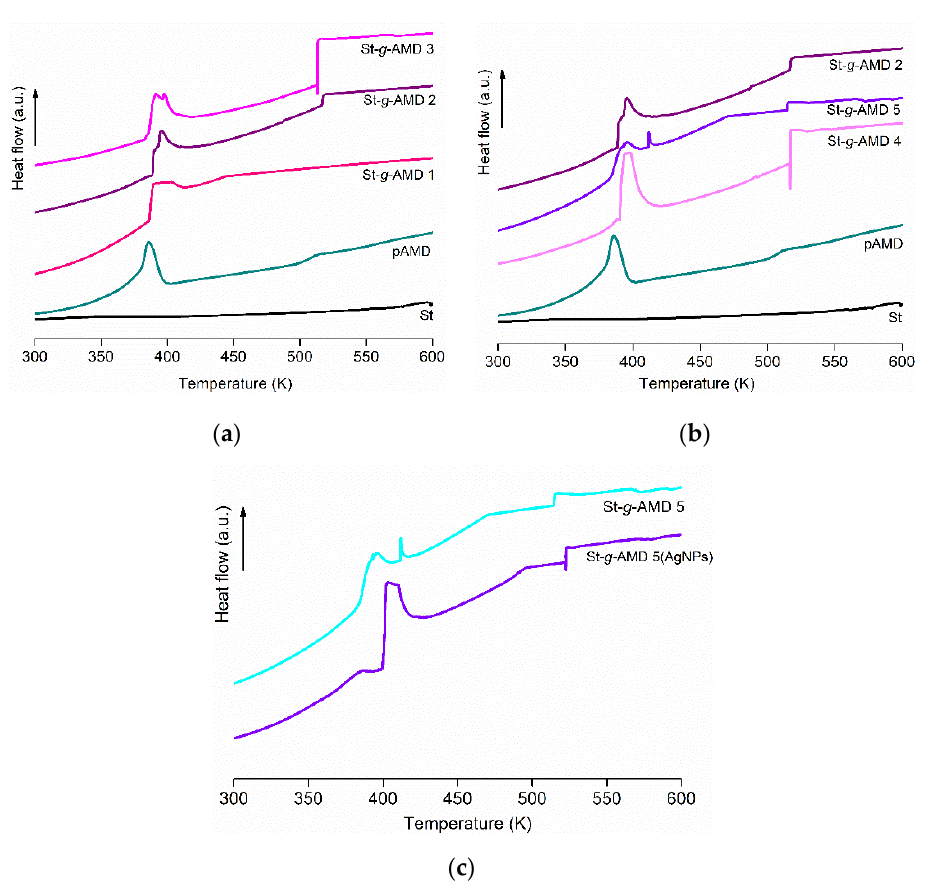
. D and . D ( Batch 2 ), and ( c ) with and without AgNPs